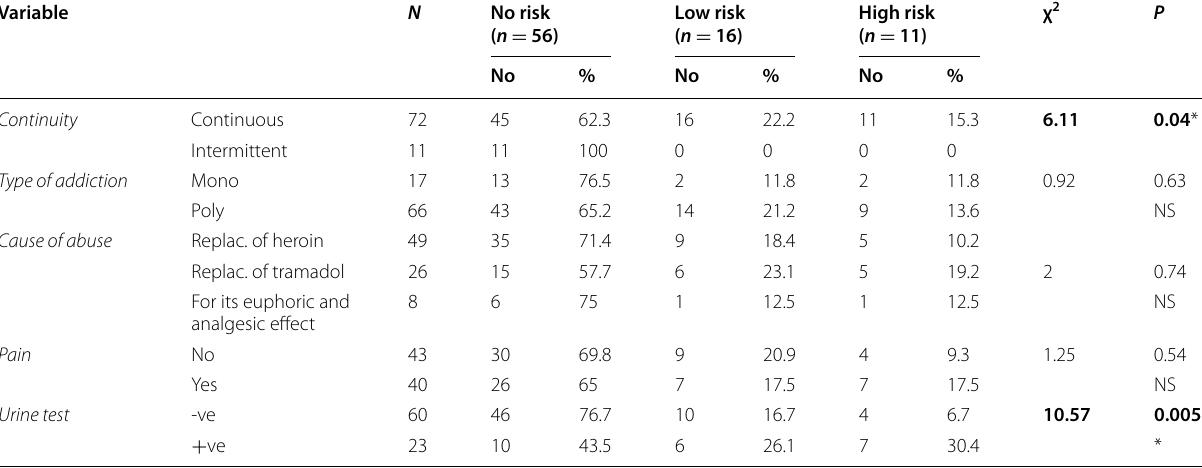
χ 2 chi-square test, NS non-significant ( P > 0.05)